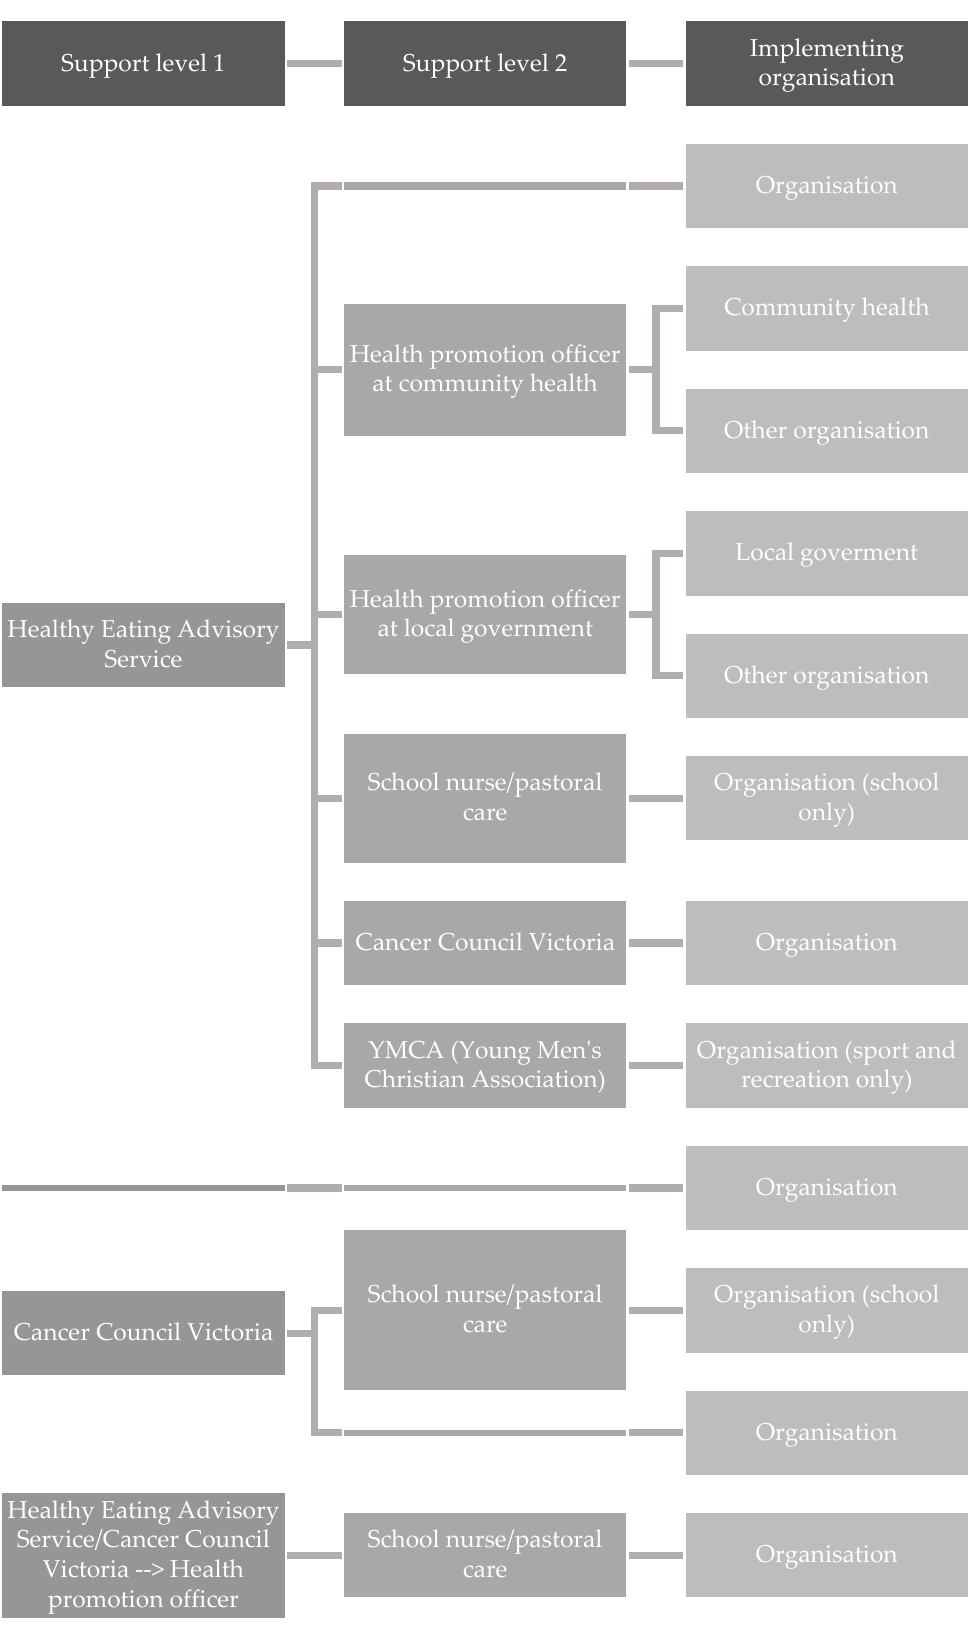
Figure 1. Current pathways of support for facilities implementing Healthy Choices Guidelines and School Canteens and Other Food Services Policy identified from the interviews.